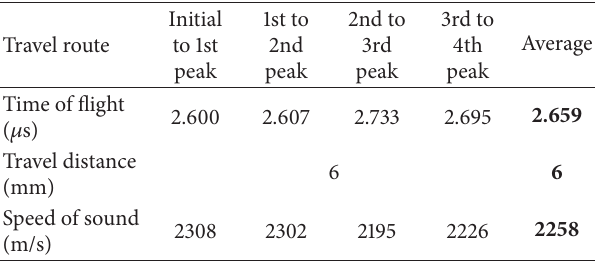
Figure 8: Signal processing of the reflected ultrasonic wave: taking absolute value of the raw signal and the filtered-out signal of the absolute value. Table 1: Time of flight and speed of